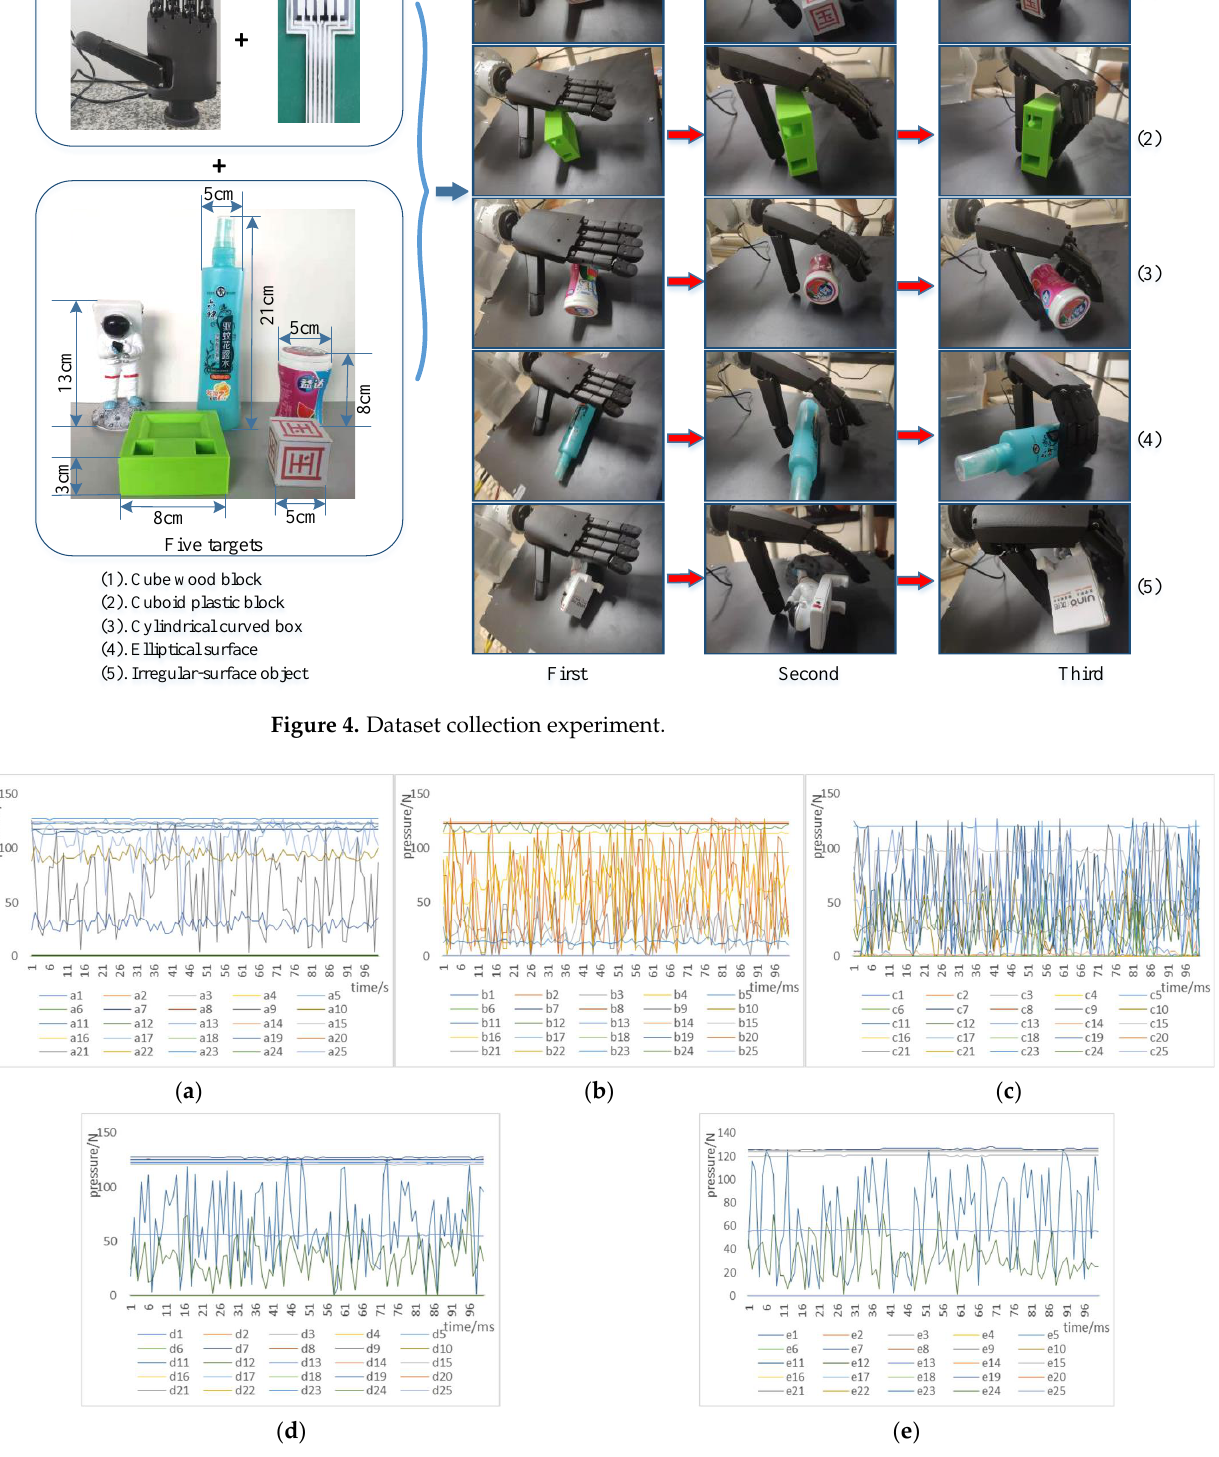
Figure 5. The pressure data curve of five fingers when grabbing an irregular surface object. ( a ) The pressure data map for thumbs. ( b ) The pressure data map of the index finger. ( c ) The pressure data map of the middle finger. ( d ) The pressure data map of the ring finger. ( e ) The pressure data map of the little finger.